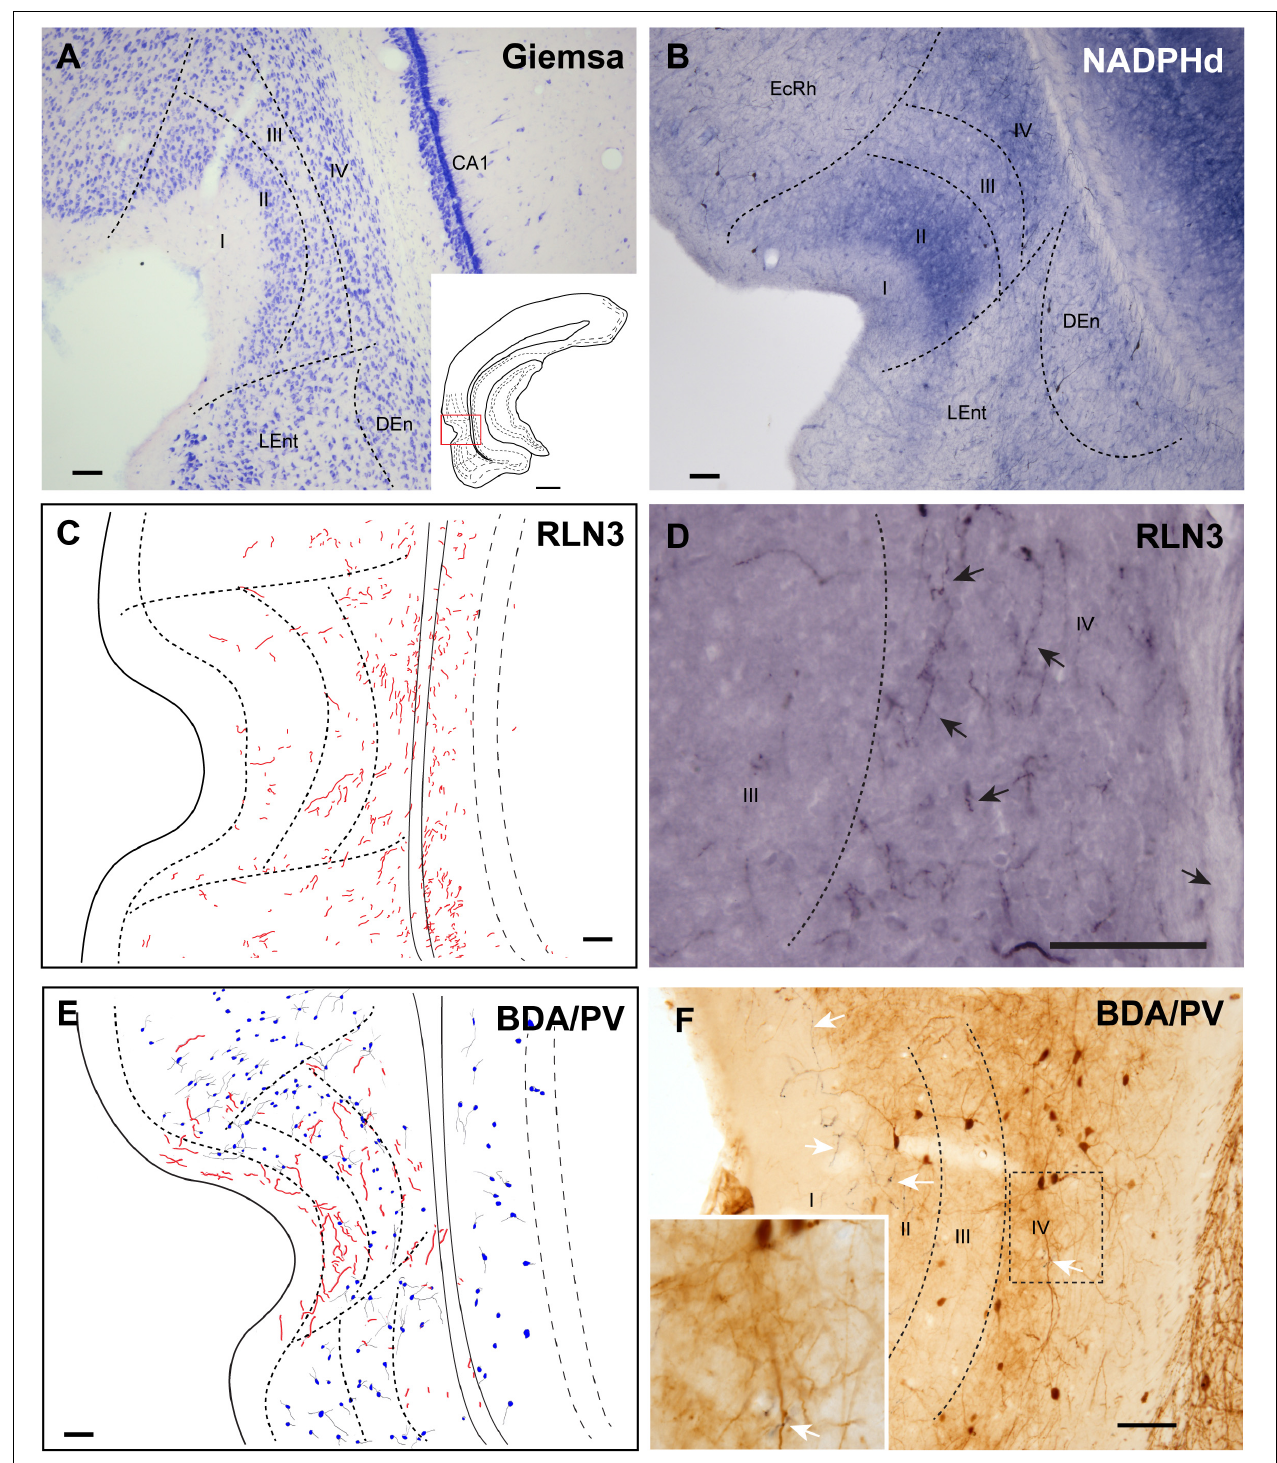
FIGURE 5 | Distribution of anterograde labeling from the NI and RLN3 staining in the perirhinal cortex. (A) Giemsa stain of the boundaries of the perirhinal cortex. (B) NADPHd histochemistry revealed strong staining in layers II and IV. (C) Camera lucida drawings of RLN3-positive fibers in case N1. (D) Photomicrograph illustrating the appearance of labeled fibers (arrows) in case N1. (E) Camera lucida drawing of sections processed for detection of BDA injected into the NI and PV in case FH54. (F) Photomicrograph illustrating the appearance of BDA labeled fibers (black) and PV neurons (brown). Arrows indicate putative contacts between BDA fibers and PV processes in case FH54. Calibration bars (A–F) 100 µ m.